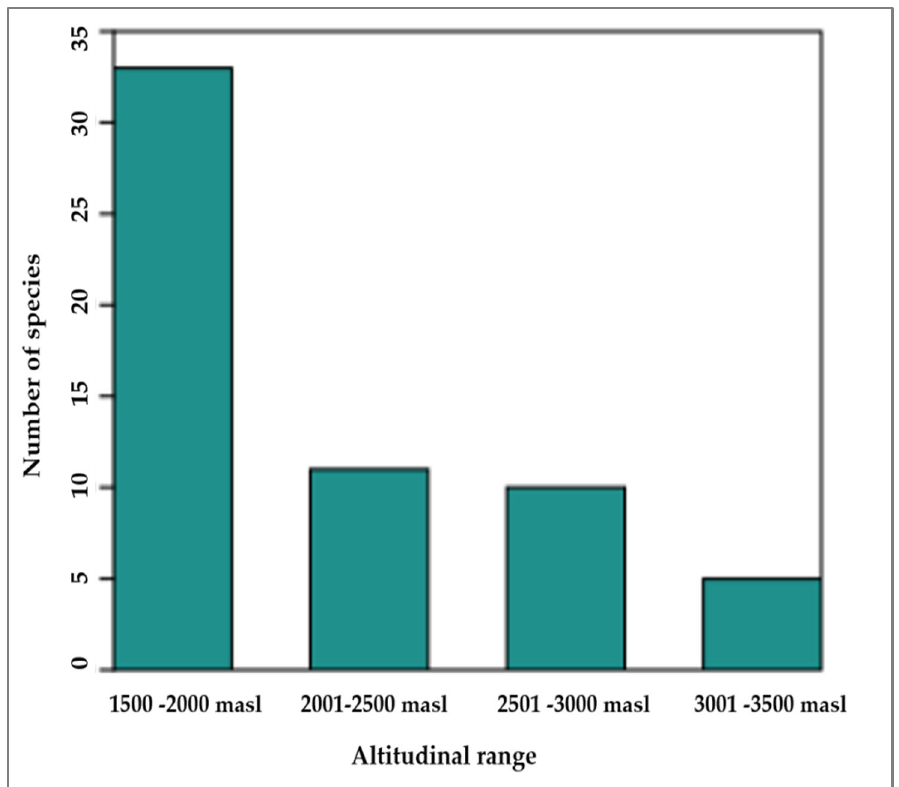
Figure 6. Altitudinal variations of the documented species in the study area.